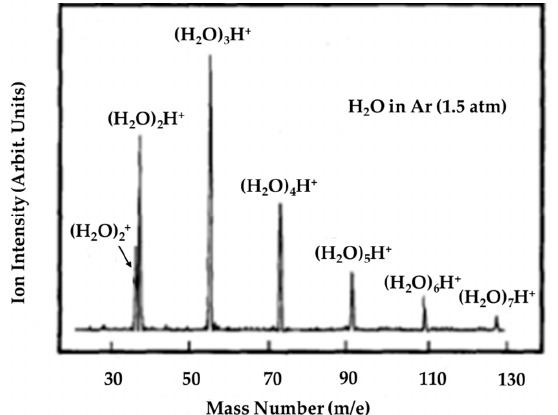
Figure 6. Photoion yield curves of (H 2 O) 2+• , H 3 O + and H 2 O +• in the spectral range 95–1120 Å. Figure adapted from [40] with permission. Copyright 1977 American Institute of Physics.